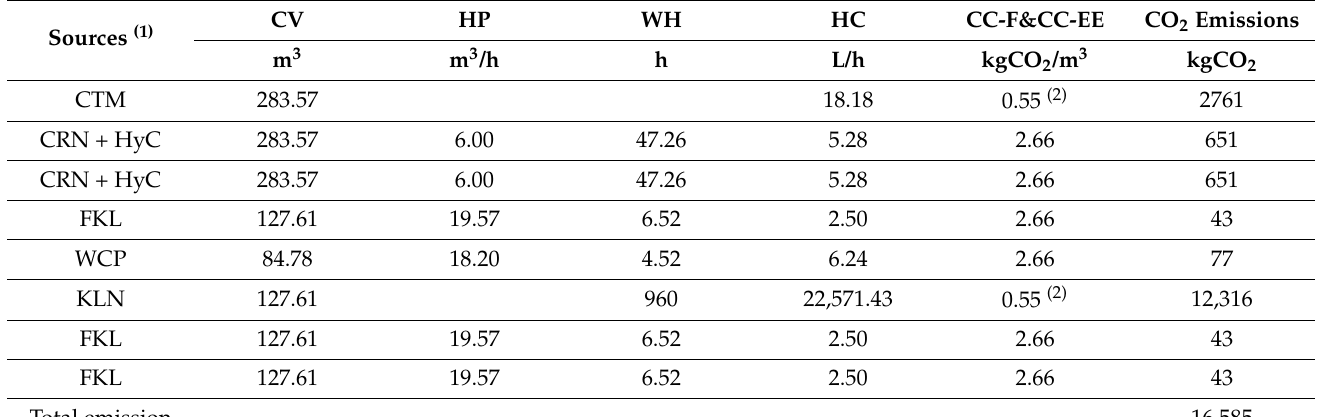
Table 9. Emissions during sawmill processing. Legend: (1) CRN + HyC: Crane + Hydraulic Clamp;